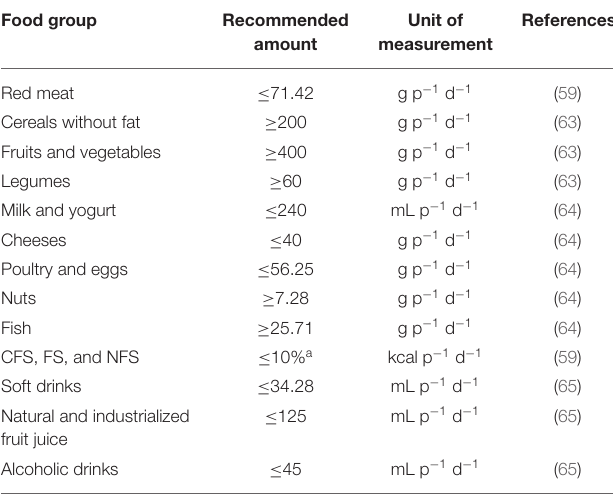
TABLE 1 | Compilation of Mexican daily dietary recommendations by food group.